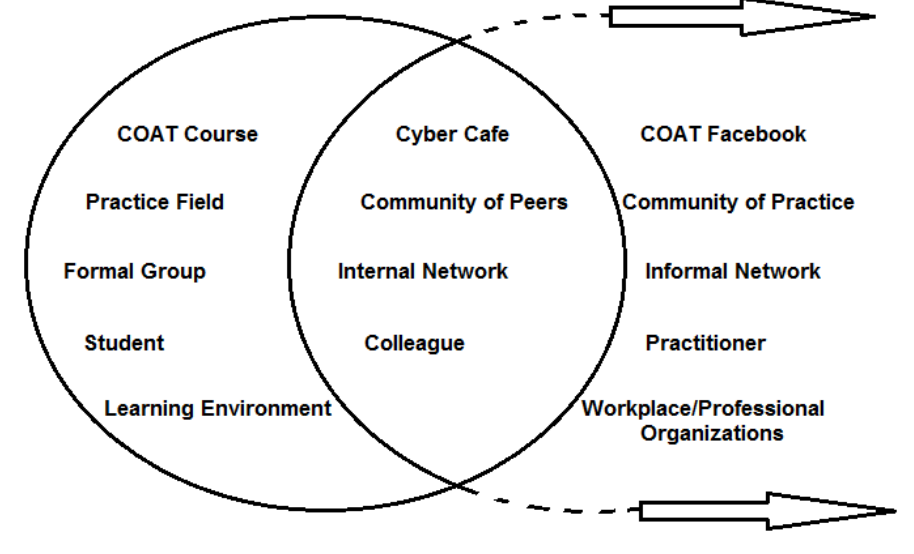
Figure 2. Networks of